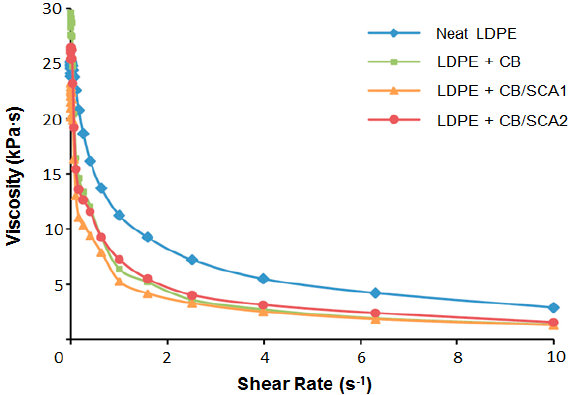
Figure 6. Viscosity as a function of shear rate LDPE and its composites with heated commercial boehmite (CB), without and with silane coupling agents (SCA1, SCA2); from [22]. Reprinted with permission. Copyright Society of Plastics Engineers, 2010.